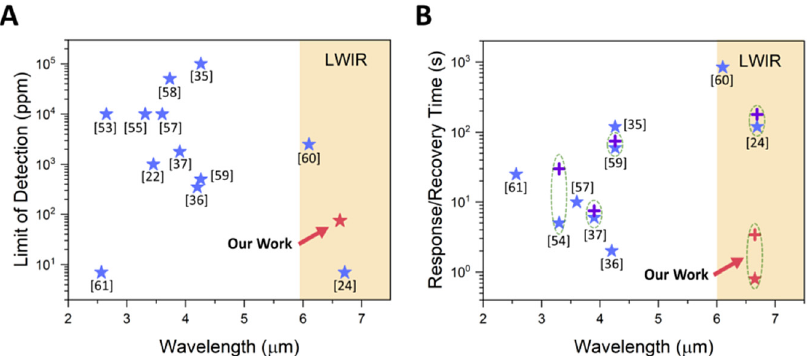
improvement. Figure 6C and D show the response and re- covery stage extracted from Figure 6B, respectively, which are fi tted with Boltzmann curves and indicate a response